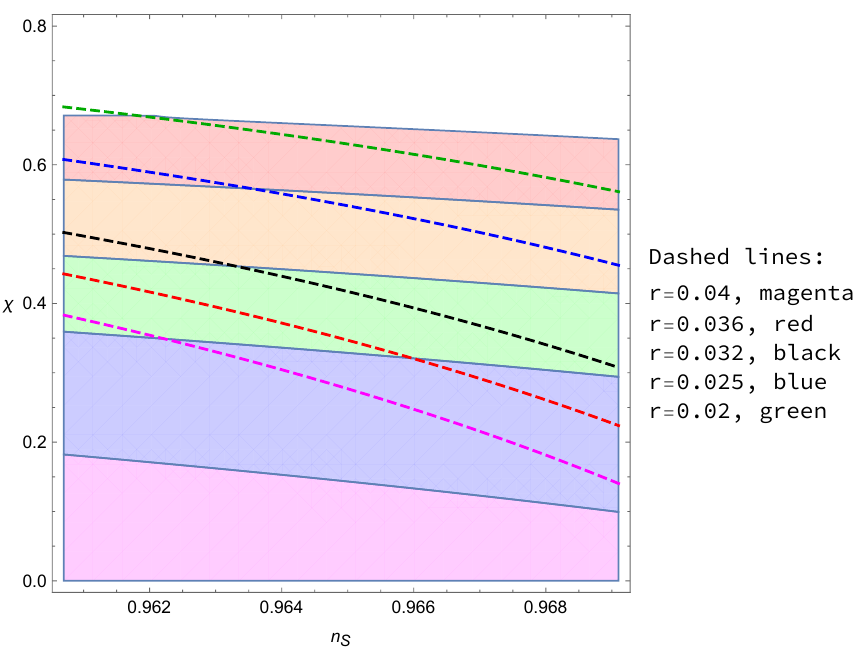
Figure 6 . Space of parameters n S and χ . Colored strips correspond to different ratios of strong coupling scale to classical scale: 1 < E strong ( k ∗ ) /E cl ( k ∗ ) < 1 . 5 (red), 1 . 5 < E strong ( k ∗ ) /E cl ( k ∗ ) < 2 . 2 (orange), 2 . 2 < E strong ( k ∗ ) /E cl ( k ∗ ) < 3 (green), 3 < E strong ( k ∗ ) /E cl ( k ∗ ) < 4 . 5 (blue), 4 . 5 < E strong ( k ∗ ) /E cl ( k ∗ ) (magenta). Dashed lines show the tensor-to-scalar ratio: r = 0 . 02 (green), r = 0 . 025 (blue), r = 0 . 032 (black), r = 0 . 036 (red), and r = 0 . 04